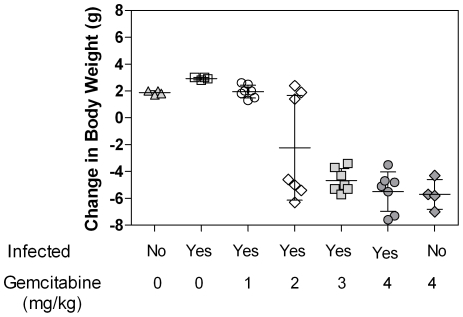
Change in body weights of mice infected with LP-BM5 MuLV and treated with the indicated doses of gemcitabine.Each symbol (triangles, squares, circles, diamonds, and hatch marks) represent one mouse. The average ± SD is shown for each treatment group.